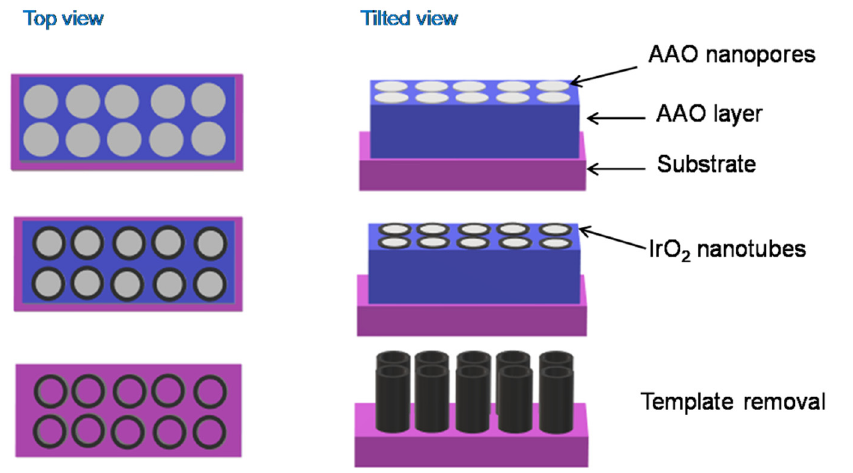
Figure 5. A schematic representation of the hard-template route for the synthesis of IrO 2 nanotubes.